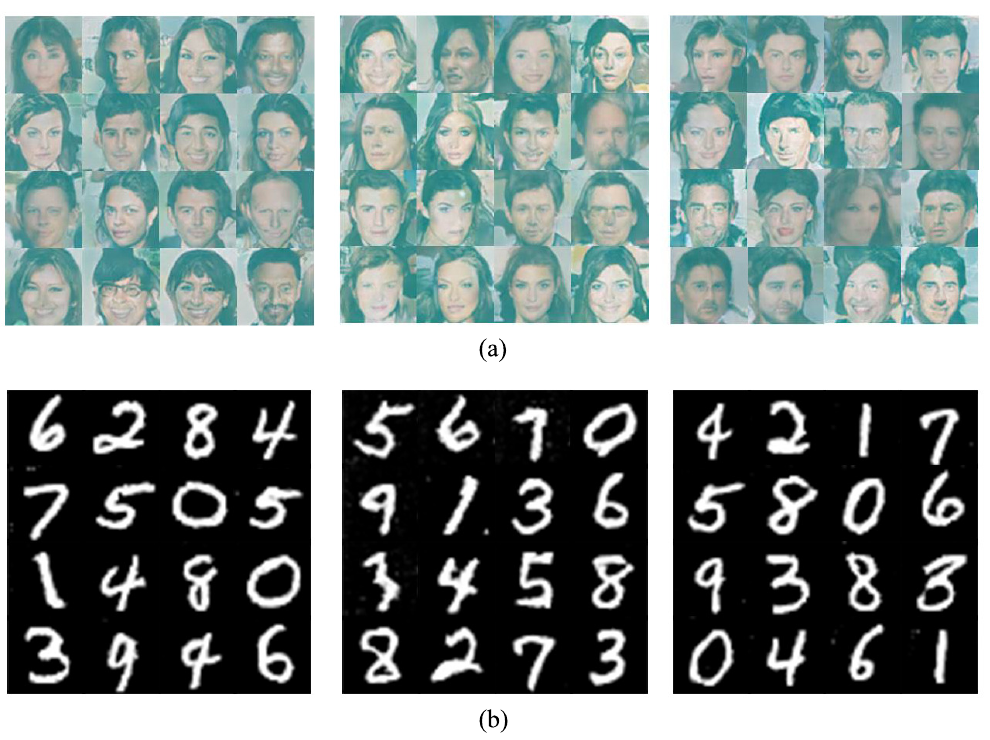
Figure 5. Data samples generated from the ( a ) CelebA dataset and ( b ) MNIST dataset with each model. From left to right, DCGAN, α -GAN, VLGAN.